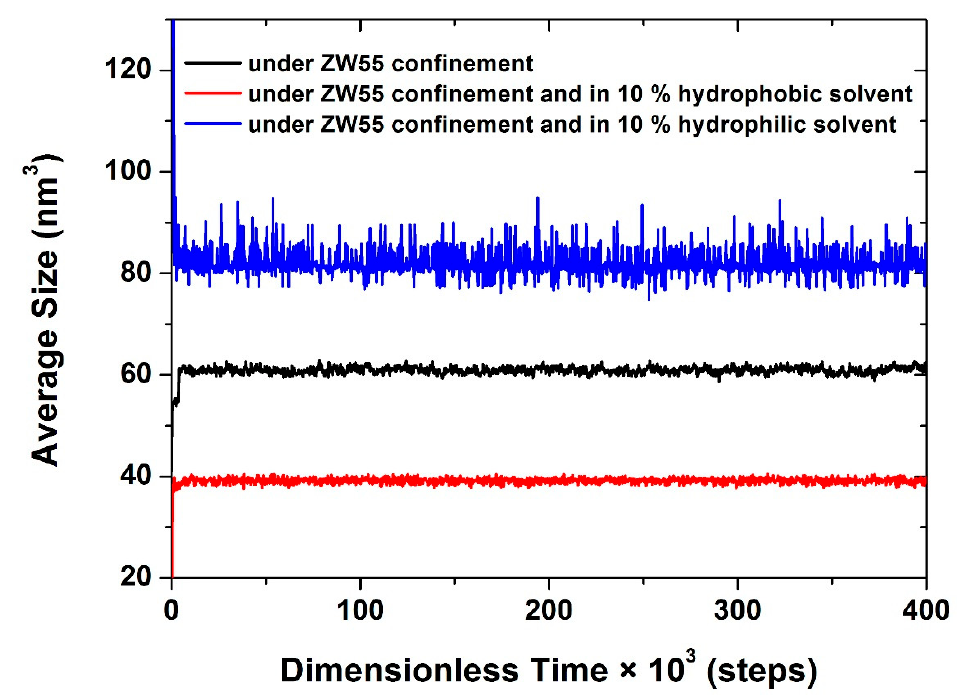
Figure 10. Average size of the self-assembled micelles in three systems over time. The system under ZW55 confinement is denoted by the black line, the system under ZW55 confinement and doped with 10% hydrophobic solvent is denoted by the red line, the system under ZW55 confinement and doped with 10% hydrophilic solvent is denoted by the blue line.